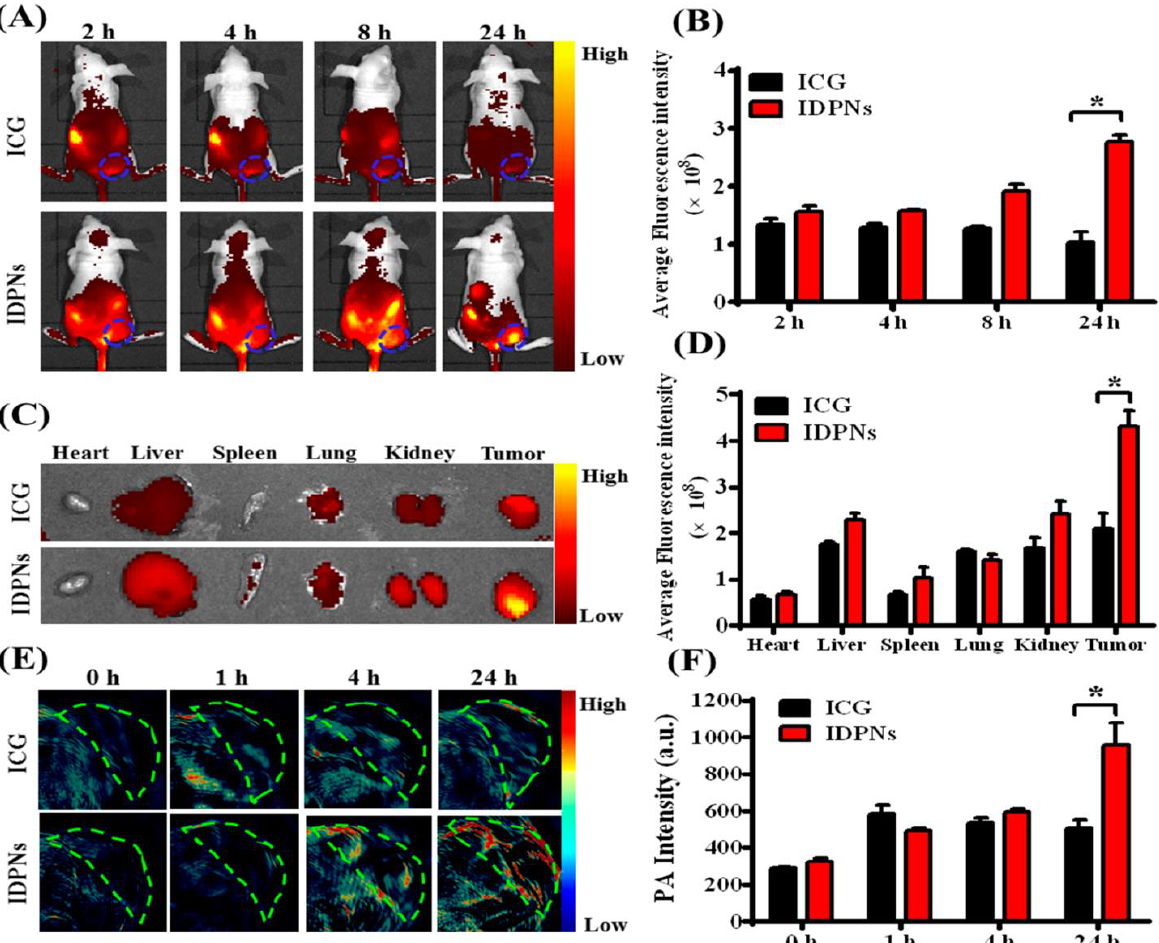
Figure 7. ( A ) Time-dependent in vivo whole-body near-infrared (NIR) fluorescence (FL) imaging of EMT-6 tumor-bearing BALB/c nude mice 2, 4, 8, and 24 h following i.v. administration of free ICG and IDPNs. Tumors are blue circles. The color bar gradually changes from red to yellow as fluorescence signal intensity increases. ( B ) Quantification of average fluorescence signals in tumor sites in part A. * p < 0.05. ( C ) The color bar gradually changes from red to yellow as fluorescence signal intensity increases. ( D ) Quantification of part C’s isolated organs and tumors’ average fluorescence signals. * p < 0.05. ( E ) Time-dependent in vivo photoacoustic (PA) imaging of EMT-6 tumors in BALB/c nude mice 0, 1, 4, and 24 h following i.v. administration of free ICG and IDPNs. Tumor locations are indicated by cycles. The color bar gradually changes from blue to red as PA intensity rises. ( F ) PA intensity quantification in part E tumor locations. * p < 0.05. The figure is adapted from [99] with copyright permission.